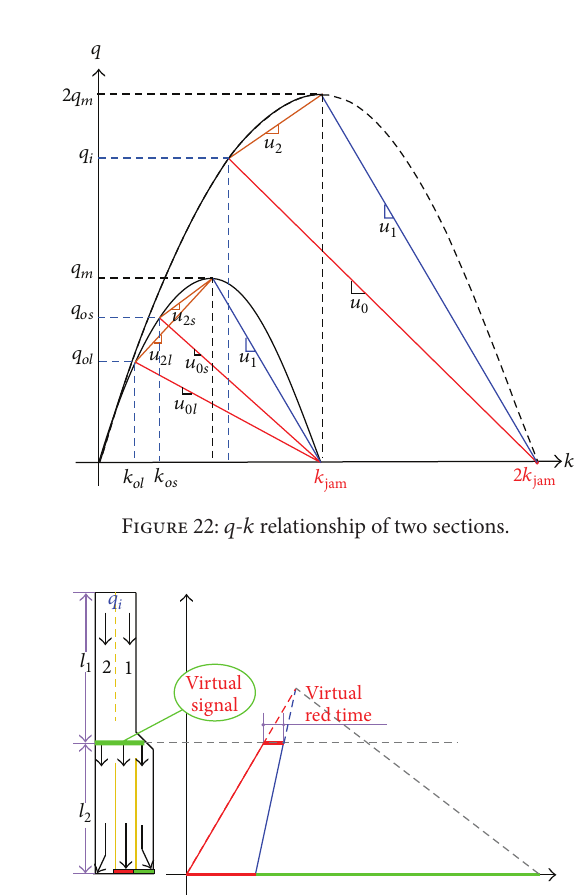
Figure 23: Virtual signal and virtual red